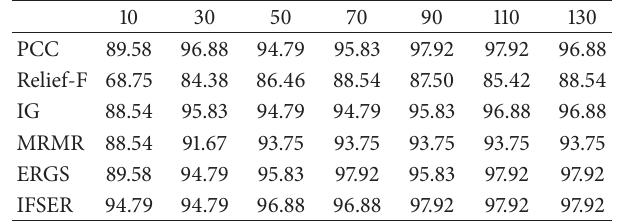
Table 1: Classification accuracies (%) of different feature selection methods with C4.5 on Lymphoma database.